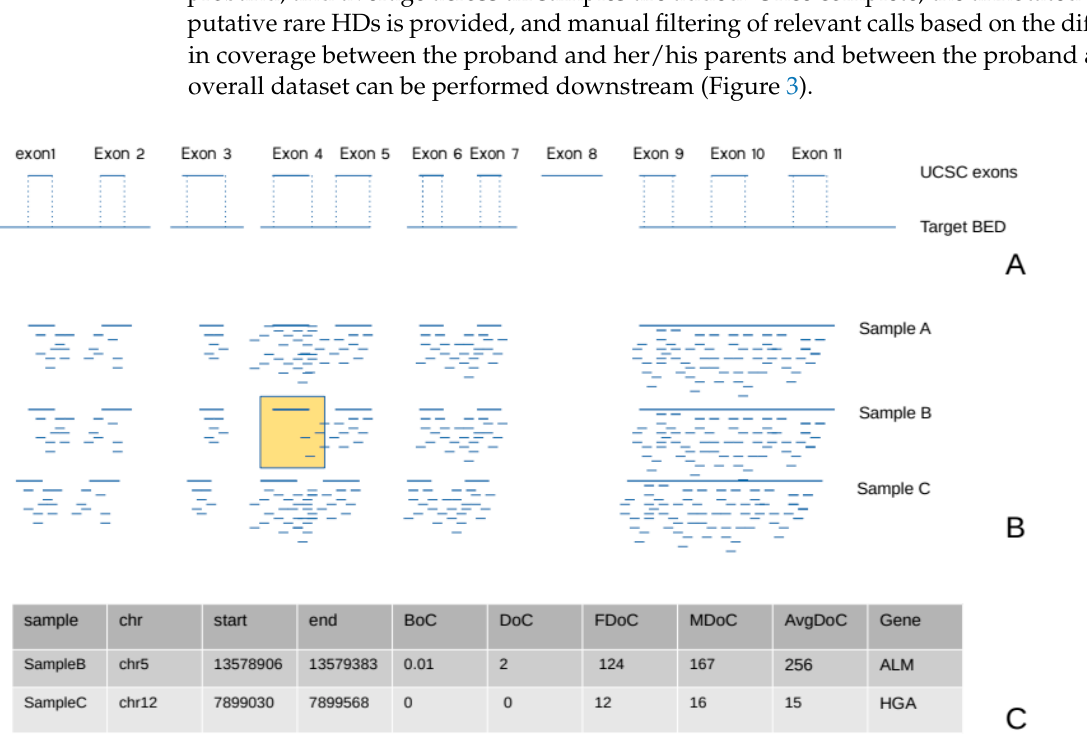
Figure 3. VarGenius-HZD algorithm and results illustration. VarGenius-HZD leverages BoC along with DoC, which is used as follows: ( A ) the target BED used for the sequencing is intersected with UCSC exon intervals to obtain an exon-on-target file, which is used to compute the BoC and DoC exploiting bedtools coverage. ( B ) NCEs for each sample are counted, and only those with frequency lower or equal to 2 are retained as putative HDs (e.g., exon 4 in ( B )). ( C ) The tabular output contains statistics for putative HDs: chromosome, start and end, the BoC for the subject sample, the DoC for the parents (FDoC and MDoC), and average exon DoC for the overall